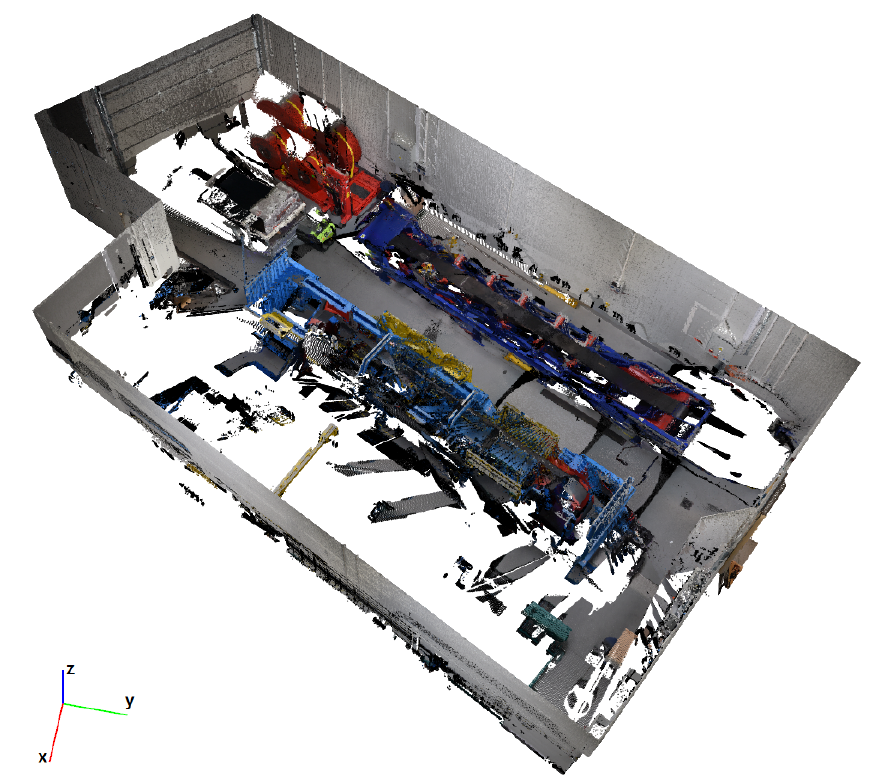
Figure 3. Reference point cloud of the inspected area